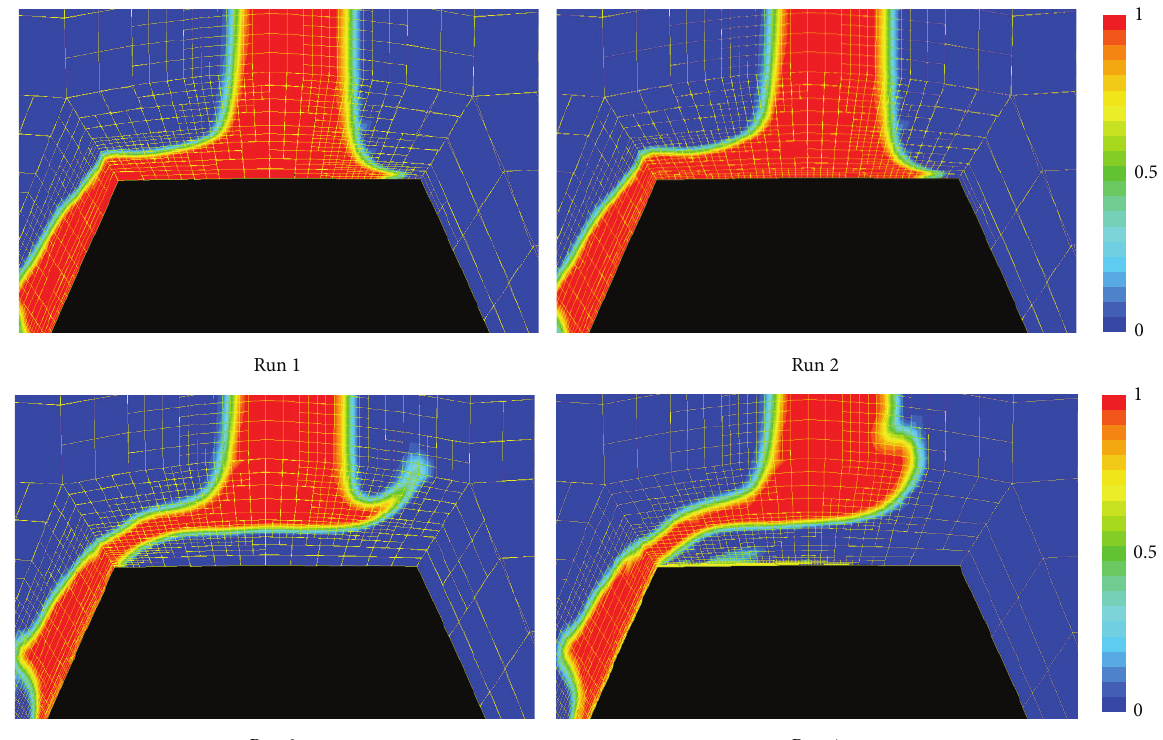
Figure 15: Contour plot of oil volume fraction at the symmetry plane: runs 1, 2, 3, and 4.